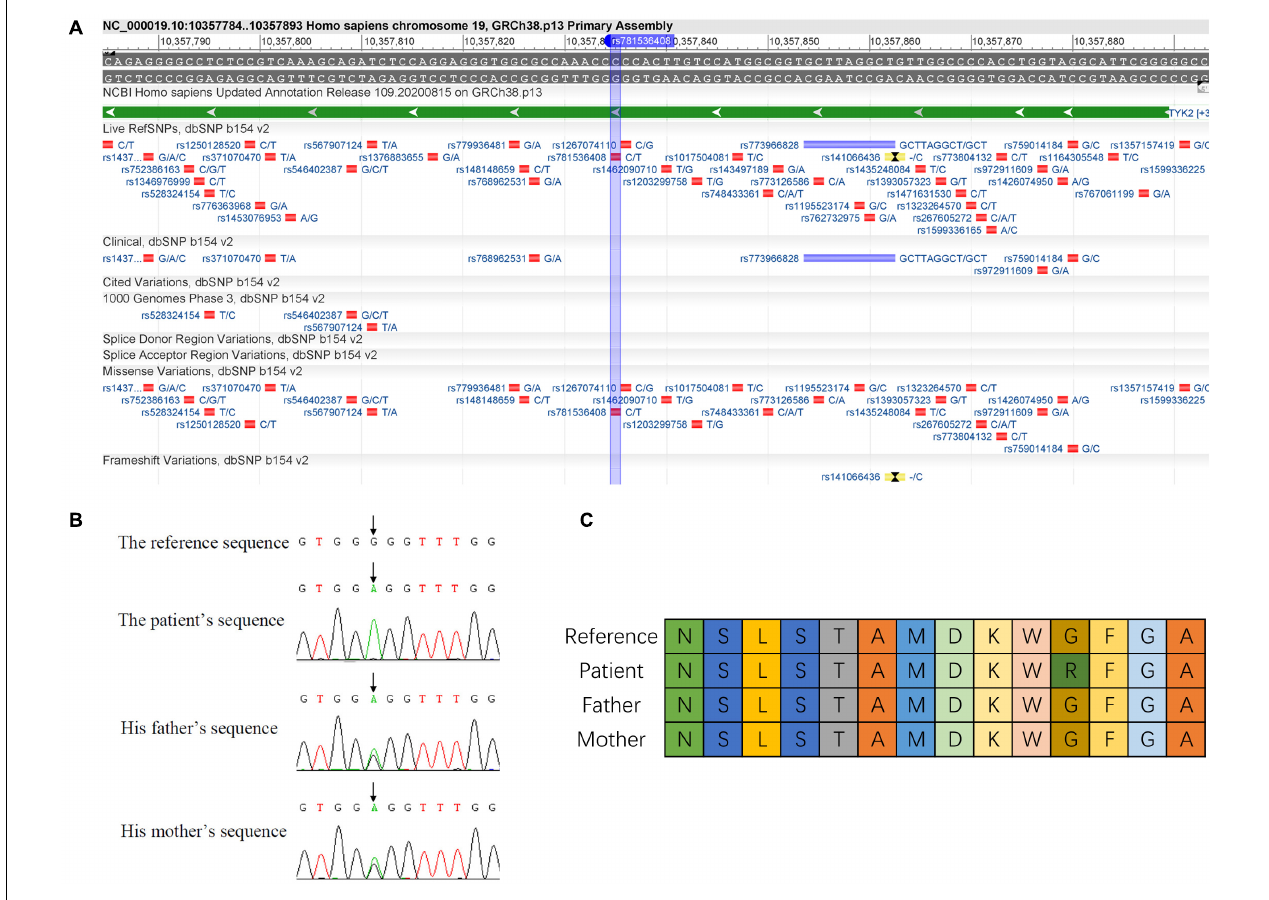
FIGURE 1 | Identification of c.2395G > A mutation in TYK2 gene. (A) Details of c.2395G > A mutation are in dbSNP database (https://www.ncbi.nlm.nih.gov/variation/view/?q=rs781536408www.ncbi.nlm.nih.gov/variation/view/?q=rs781536408). (B) Sanger sequencing results of the family. (C) Variation of amino acid sequence caused by c.2395G > A mutation (differently colored boxes represent different amino